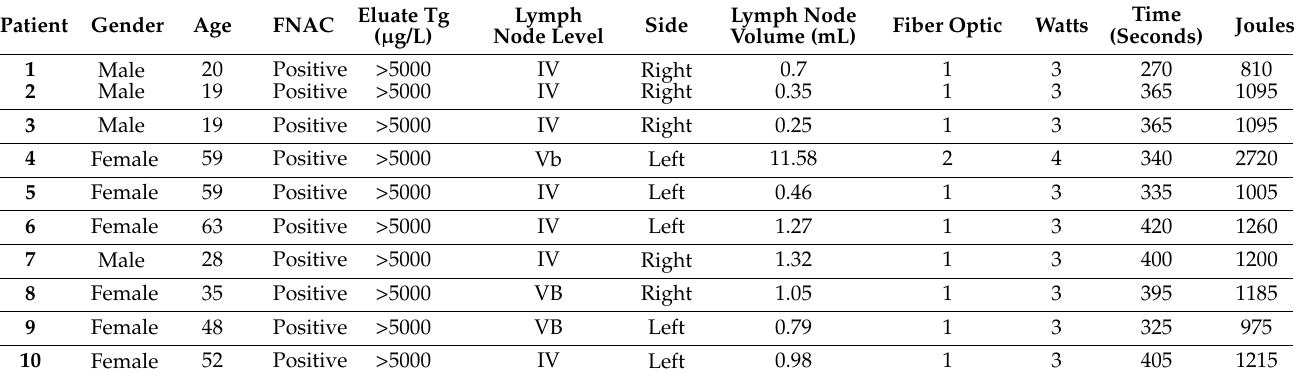
Table 2. Demographic and clinical data of the included